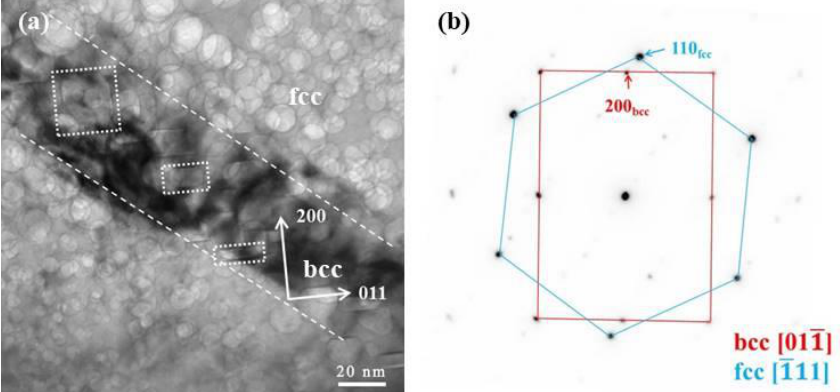
Figure 7. ( a ) Faceted helium bubbles in an α’-martensite lath (bcc phase). The orientation relationship between γ-austenite and α’-martensite was determined by ( b ) the SAD pattern, {111} γ //{011} α’ , [101] γ //[111] α